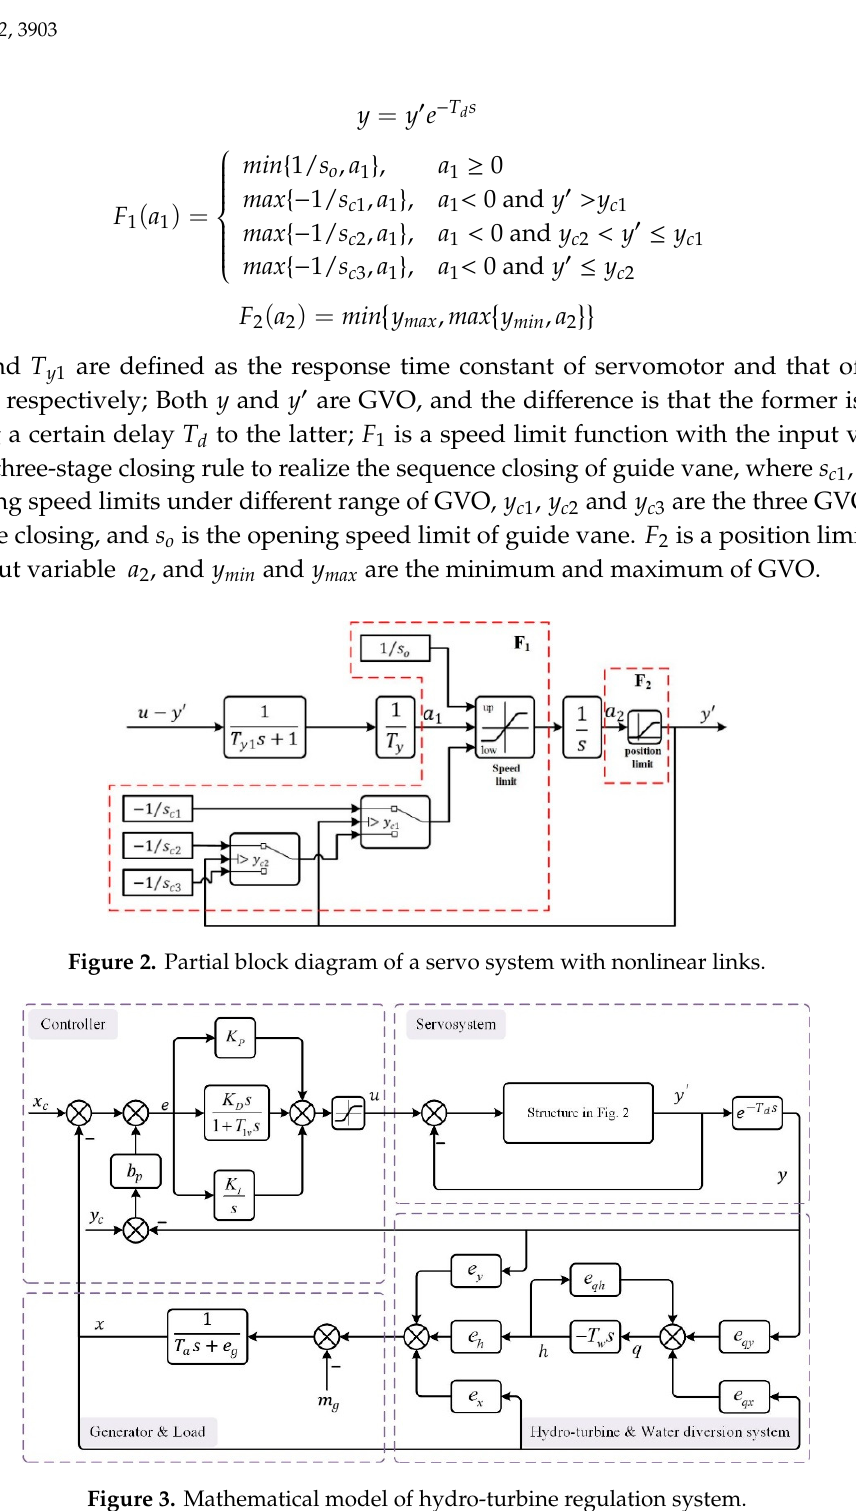
Figure 3. Mathematical model of hydro-turbine regulation system.